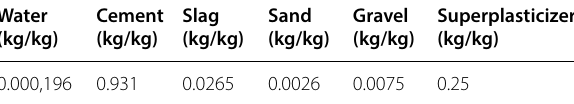
Table 1 CO emissions of concrete 2